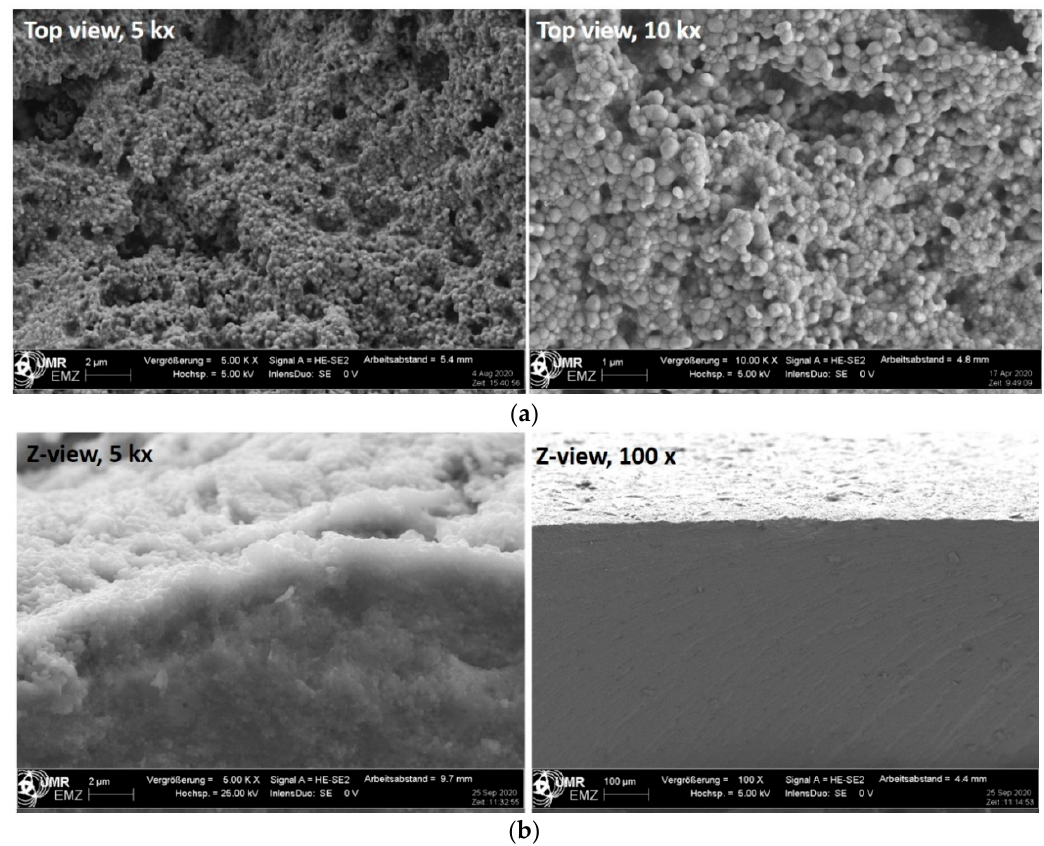
Figure 1. Scanning electron microscopy of the cer.face 14 ceramic. ( a ) Surface topography. Note a landscape with nano-micro hills and cavities, nearly sinusoidal-shaped, (bars: left 2 µm, right 1 µm). ( b ) Cross section of the material. No different layers were apparent, (bars: left 2 µm, right 100 µm). (FE-SEM Merlin, Carl Zeiss).